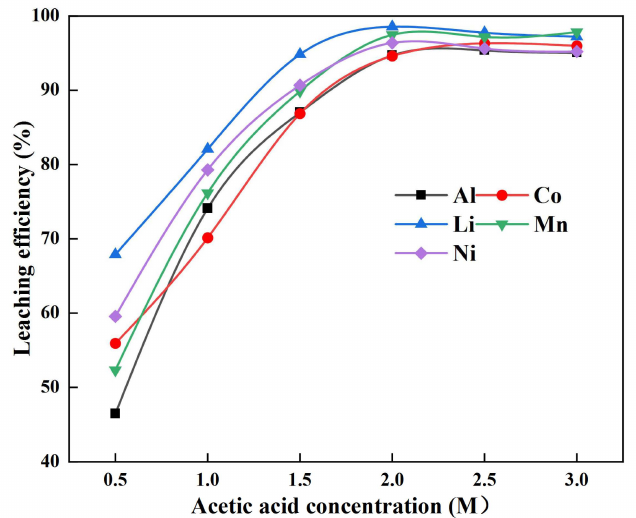
Figure 3. Effect of acetic acid concentration on the leaching of metals from electrode materials.